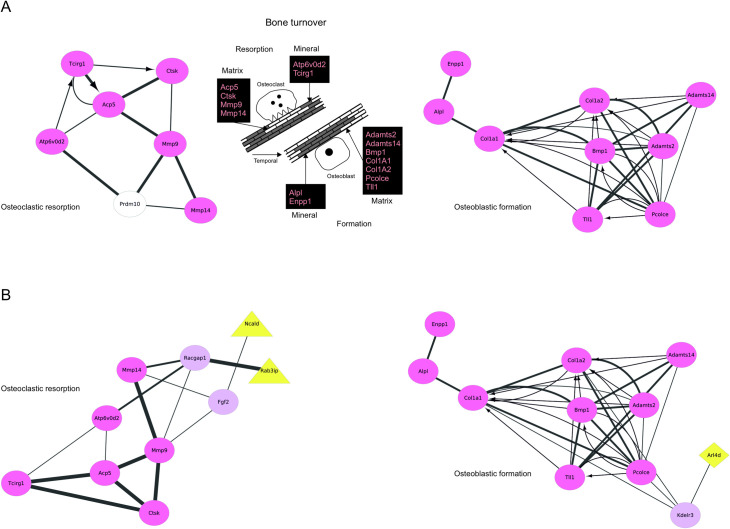
An in silico bone turnover model validated class 2 candidate BMD genes.(A) The in silico model of bone turnover captured the extracellular break down of bone and the subsequent formation of new bone. The model is simplified excluding for example many of the intracellular proteins driving bone turnover or non-collagenous matrix proteins. While resorption of both bone matrix and mineral may occur concurrent, bone matrix formation typically precedes mineral deposition. The genes mainly responsible for bone turnover were grouped and annotated as follows. Osteoclastic bone matrix resorption: tartrate-resistant acid phosphatase type 5 (Acp5), essential for osteoclast motility; cathepsin K (Ctsk), matrix break down; matrix metallopeptidase 9, (Mmp9), matrix break down; matrix metallopeptidase 14 (Mmp14), matrix break down. Osteoclastic bone mineral resorption: ATPase H+ transporting V0 subunit D2 (Atp6v0d2), acidic pH and mineral removal; ATPase H+ transporting V0 subunit A3, (Tcirg1), acidic pH and mineral removal. Osteoblastic bone matrix formation: ADAM metallopeptidase with thrombospondin type 1 motif 2. (Adamts2), N-terminal processing of procollagen; ADAM metallopeptidase with thrombospondin type 1 motif 14 (Adamts14), N-terminal processing of procollagen; bone morphogenic protein 1 (Bmp1), C-terminal processing of procollagen; collagen type I alpha 1 chain (Col1a1) and collagen type I alpha 2 chain (Col1a2), procollagen formation; procollagen C-endopeptidase enhancer 1 (Pcolce), enhancer of C-terminal processing of procollagen; tolloid like 1 (Tll1), C-terminal processing of procollagen. Osteoblastic bone mineral deposition: tissue-nonspecific alkaline phosphatase (Alpl), removal of mineralization inhibitor inorganic pyrophosphate (PPi); ectonucleotide pyrophosphatase/phosphodiesterase 1 (Enpp1), production of PPi. Together, these proteins (red elliptic nodes) formed the PPI networks for osteoclastic resorption and osteoblastic formation during bone turnover. Connecting proteins distinct from the bone turnover genes are represented as pink elliptic nodes, while white nodes marked genes with an undefined role in bone. Black lines represent PPIs as determined by STRING or REACTOME analysis. Arrows indicated REACTOME-curated data. For validation, we used experimental gene expression data from osteoclasts and osteoblasts in combination with statistical testing. The resulting gaussian probability of interactions, i.e. FDR-adjusted p-values (q-values) were superimposed on the STRING PPIs as follows: large line width, q<0.0005; medium line width, q<0.05; small line width, q>0.05 or no q data. (B) Based on their cellular expression, the three class 2 low BMD candidate genes Rab31p, Ncald, and Arl4d were probed in the osteoclastic and osteoblastic compartments of bone turnover. Rab3ip and Ncald interacted via single intermediates with proteins degrading bone matrix and also mineral, while Arl4d, also via an intermediate, interacted with a regulator of the procollagen cleavage essential for bone matrix formation.